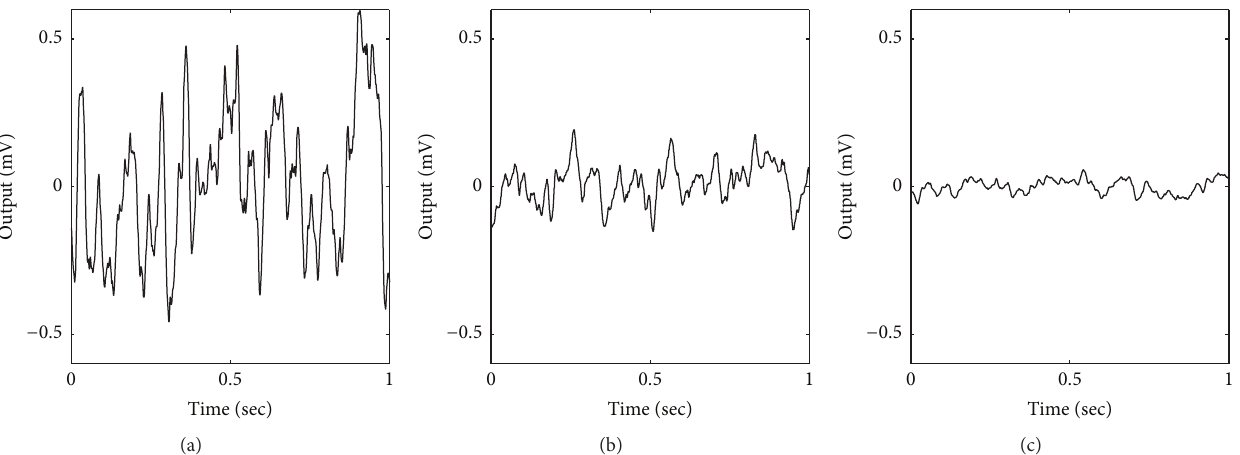
Figure 3: Examples of using the 4th-order Runge-Kutta method, as in Wendling et al. [18]. (a) For integration step size of 1ms, the variance ( 𝜎 2 ) of the output is 0.0751. (b) For integration step size of 0.1ms, 𝜎 2 is 0.0065. (c) For integration step size of 0.01 ms, 𝜎 2 is 0.0006. Variances were computed using 10 seconds of output. Model parameters: 𝐴 = 5 , 𝐵 = 40 , and 𝐺 = 20